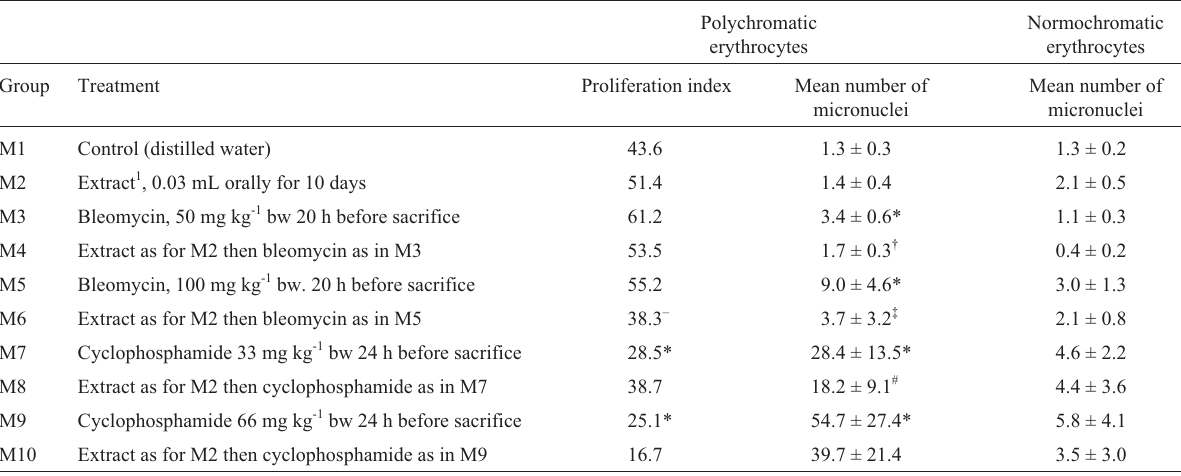
Table 1 - The number of polychromatic erythrocytes as a percentage of the total number of erythrocytes (the proliferation index) and the mean number of micronuclei in polychromatic and normochromatic erythrocytes of Swiss albino mice of both sexes treated orally with 0.03 mL of Caryocar brasiliense (pequi) aqueous extract, equivalent to 1 mL kg -1 body weight (bw), alone or with a single intraperitoneal bleomycin or cyclophosphamide injection administered 20 h before sacrifice for bleomycin and 24 h before sacrifice for cyclophosphamide. Each group contained eight mice. Significant differences by the Mann-Whitney U test are shown for the polychromatic